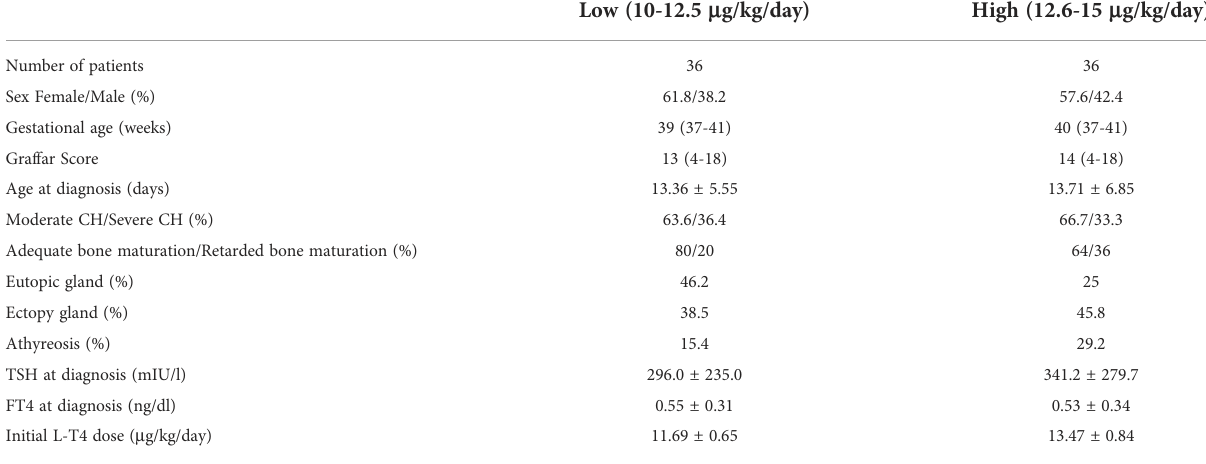
Data are expressed as percentage, median and range or mean ± standard